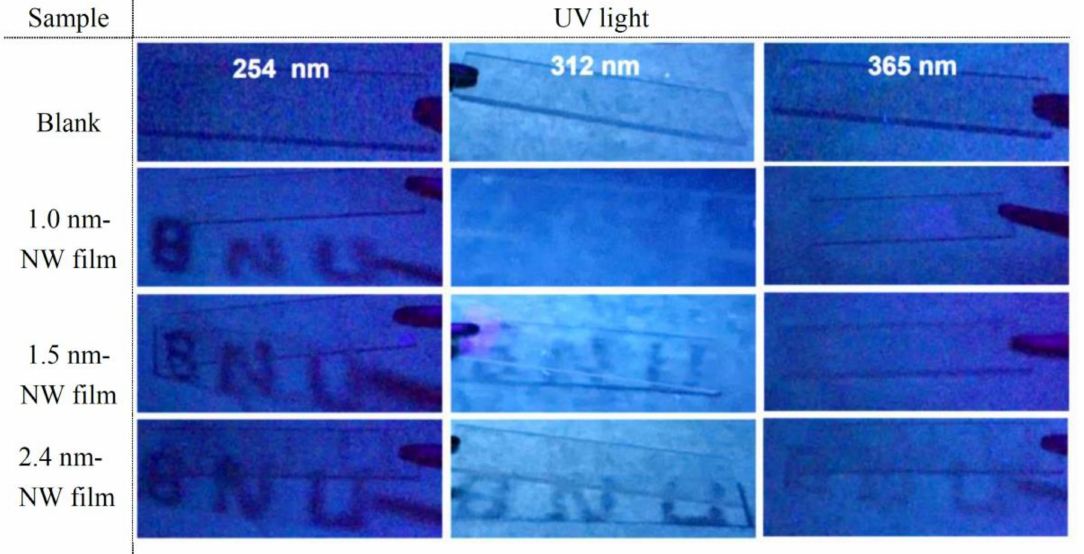
Figure 5. Optical images recording the optical transparencies of four quartz sheets coated with or without (blank) a “BNU” pattern under different ultraviolet (UV) wavelength illumination. The patterns were fabricated by drop-casting a small volume of chloroform solutions containing the as-prepared ZnS USNWs of various diameters onto three quartz sheets via a homemade PDMS mold,